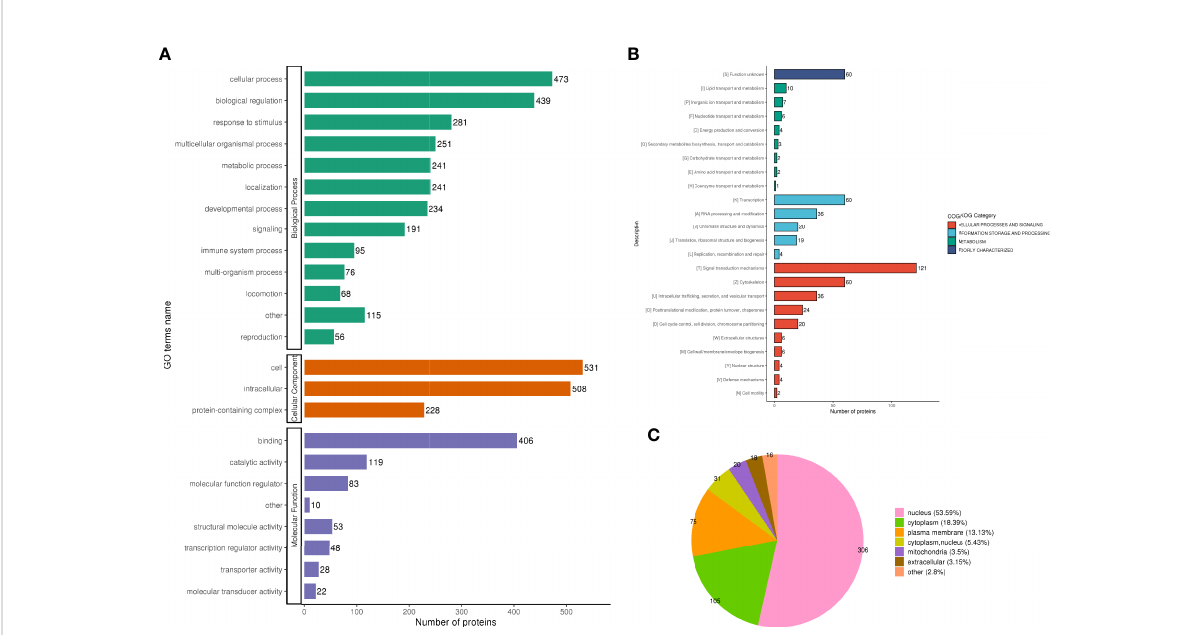
FIGURE 7 Functional classi fi cation of DPPs. GO classi fi cation analysis, the two biological processes with the greatest changes in DPPs are cellular progression and biological regulation, the cellular components are mainly cells and intracellular fl uids, and the molecular functions are mainly protein binding and catalytic activity (A) . subcellular localization analysis, 571 phosphorylated proteins were quantitatively distributed in the nucleus (53.59%), cytoplasm (18.39%), and plasma membrane (13.13%) (B) . COG functional classi fi cation, most of the phosphorylated proteins that can be quanti fi ed are mainly in the categories of signal transduction mechanism (121 DPPs), transcription (60 DPPs), and cytoskeleton (60 Dpps) (C)